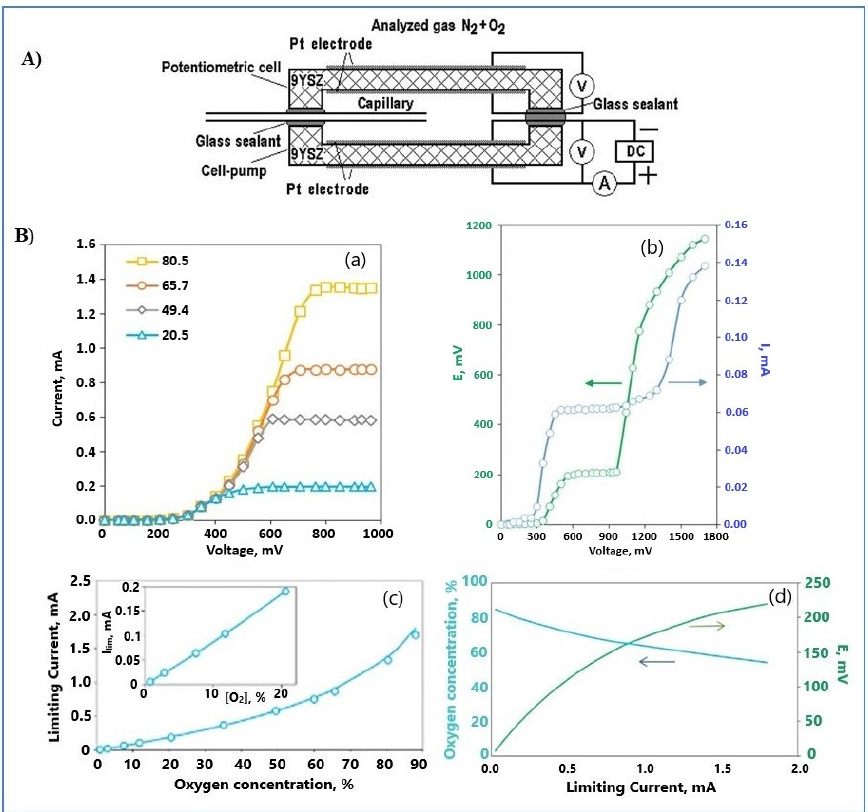
Figure 7. ( A ) Scheme of a combined potentiometric/amperometric oxygen sensor. ( B ) The sensor characteristics. (a) Current–voltage curves at 500 °C, (b) typical EMF-V and I-V characteristics at 500 °C and oxygen’s concentration of 7.5, (c) relation between limiting current and oxygen concentration at 500 °C, (d) calibration curves at 500 °C for the determination of oxygen’s concentration through limiting current ( green line ), and dependence of the EMF on the limiting current ( blue line ). Reproduced with permission from [69].